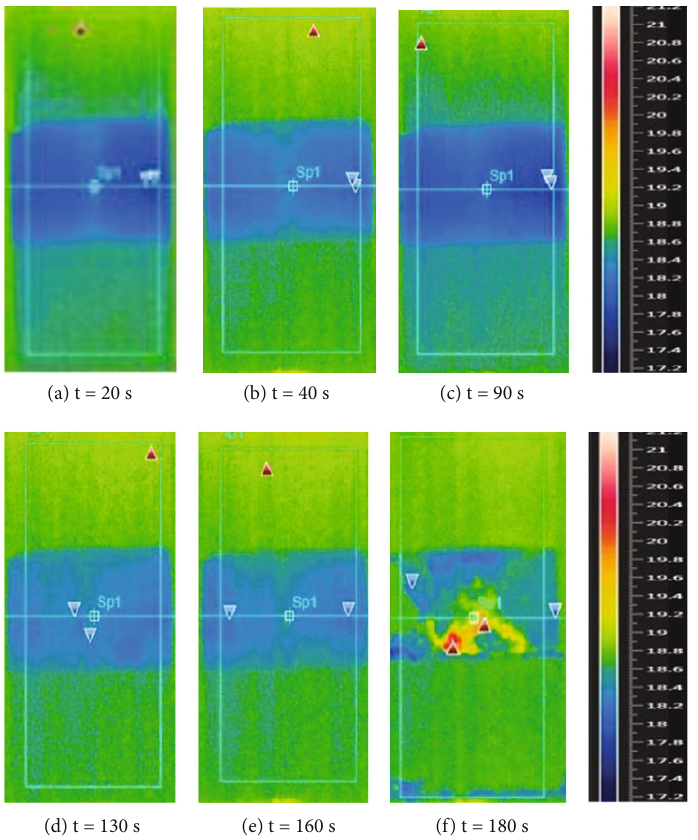
Figure 11: Thermal imaging of the sample 11 # . Here, (a), (b), (c), (d), (e), and (f) are the thermal infrared imaging images of the sample 11 # at the rate of 0.05MPa/s when the experimental times are 20s, 40s, 90 s, 130s, 160 s, and 180 s, respectively. Among them, 160s is the thermal infrared image after the con fi ning pressure has just been